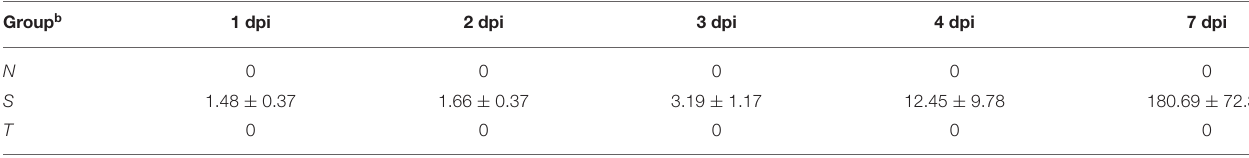
TABLE 1 | Number of T. gallinae in the oral cavity of squabs at different days post infection (dpi) a . Group